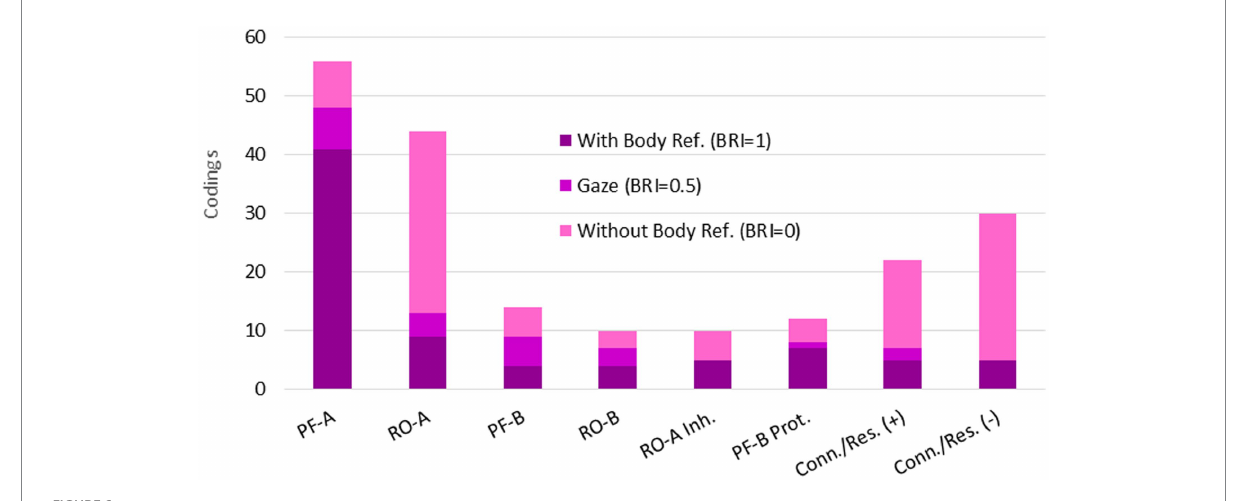
FIGURE 6 Level 3: Body reference in mental